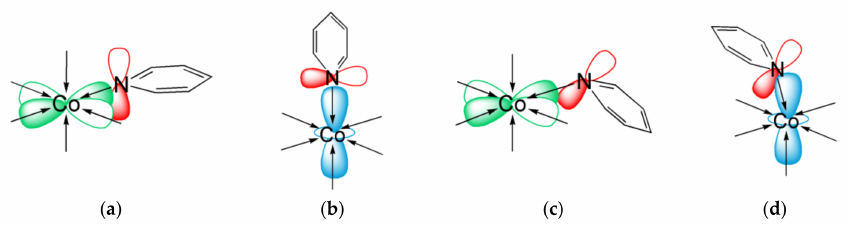
Figure 4. Schematic drawing of the absence or presence of orbital overlaps. ( a , b ) Geometries of ( a ) the Co 3d x 2- y 2 and N 2p z orbitals or ( b ) Co 3d z 2 and N 2p z orbitals with a negligible angular torsion. ( c , d ) With an appreciable angular